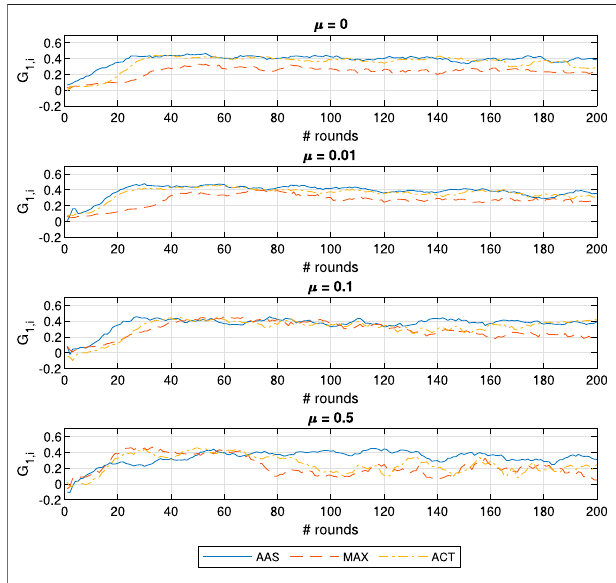
FIGURE 8 | Contribution evolution for learner k (cid:2) 1 in the case of using the FMNIST dataset with an extra CNN layer.